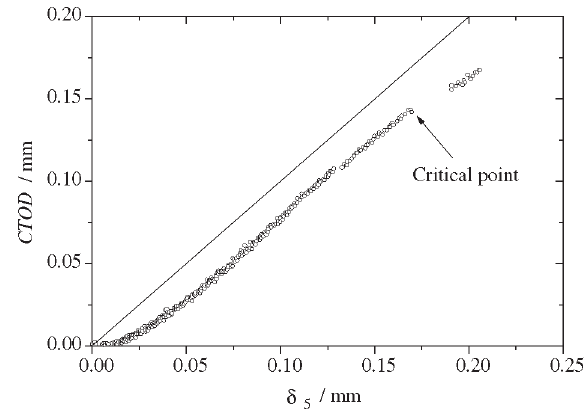
curve of ARALL 2 3/2 (test specimen B). 5